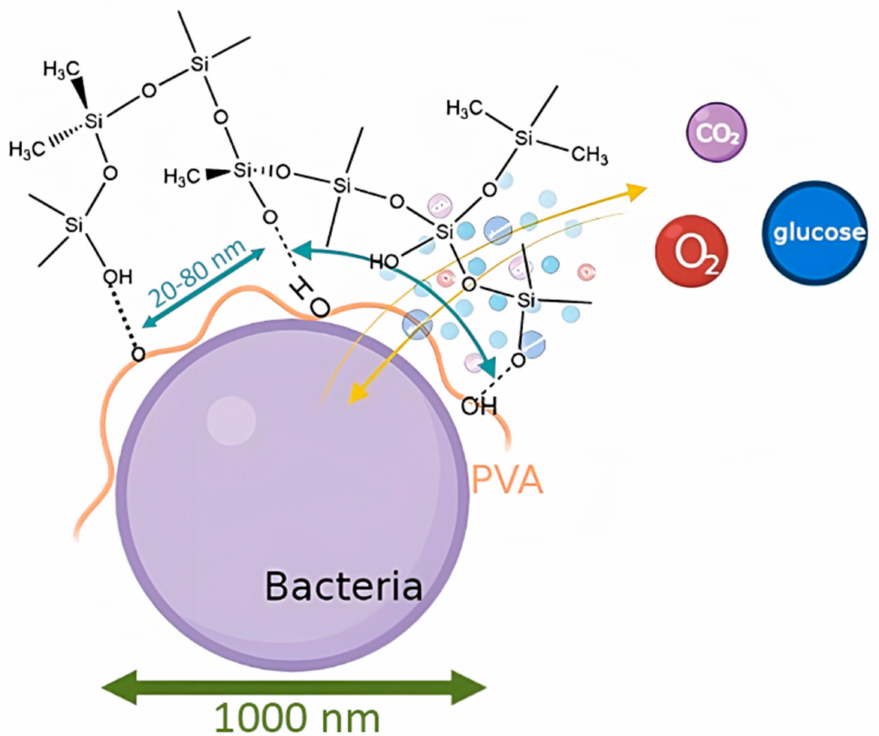
Figure 5. Proposed model for the formation of a sol–gel matrix around microorganism cells. The obtained biohybrids were analyzed by the method of low-temperature nitrogen adsorption to determine their porosity and specific surface area; the results are shown in Figure 6.